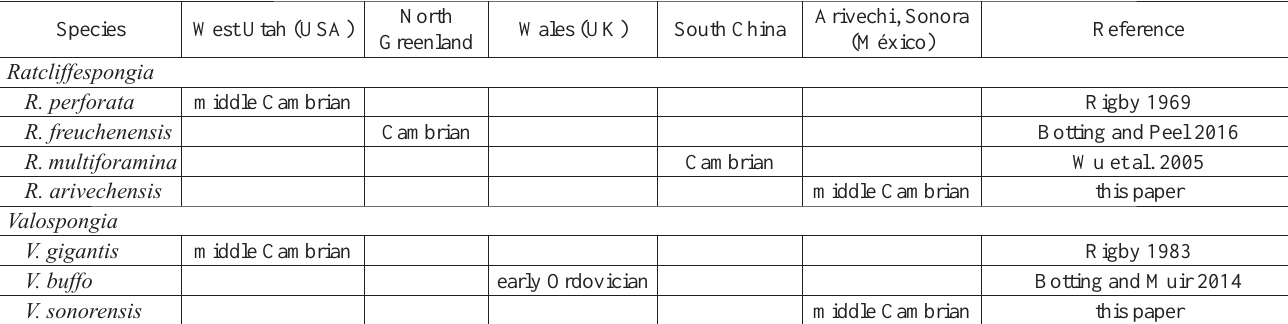
Table 3. Distribution of the sponges found in the Arivechi locality in comparison with other regions.